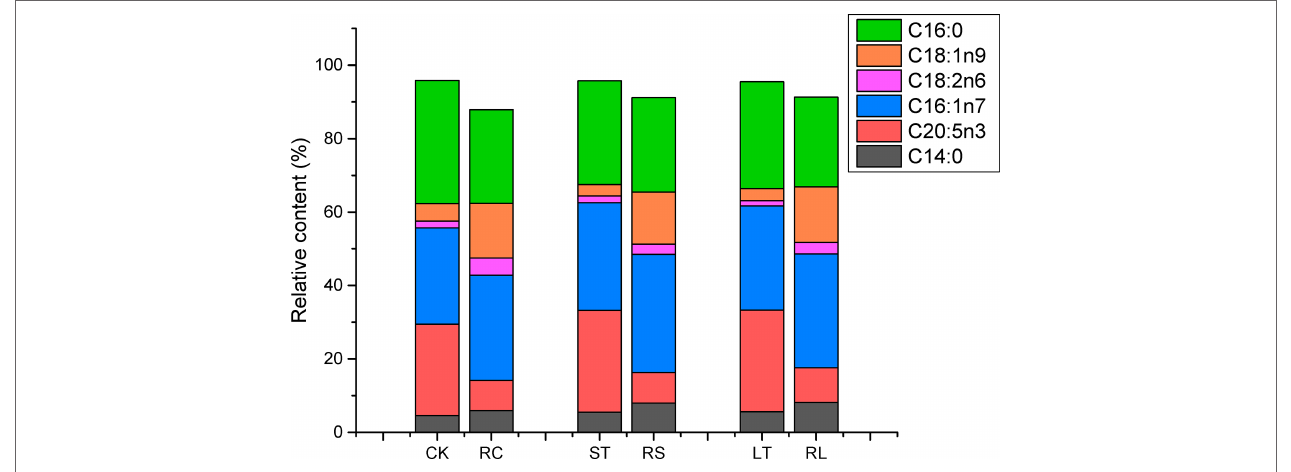
FIGURE 8 | Changes of main fatty acid profiles of N. oceanica (CK, ST and LT) and rotifer ( B ) plicatilis (RC, RS and RL) under different treatment treatments. CK, control; ST, short-term acidification; LT, long-term acidification. RC, rotifer fed with CK; RS, rotifer fed with ST; RL, rotifer fed with